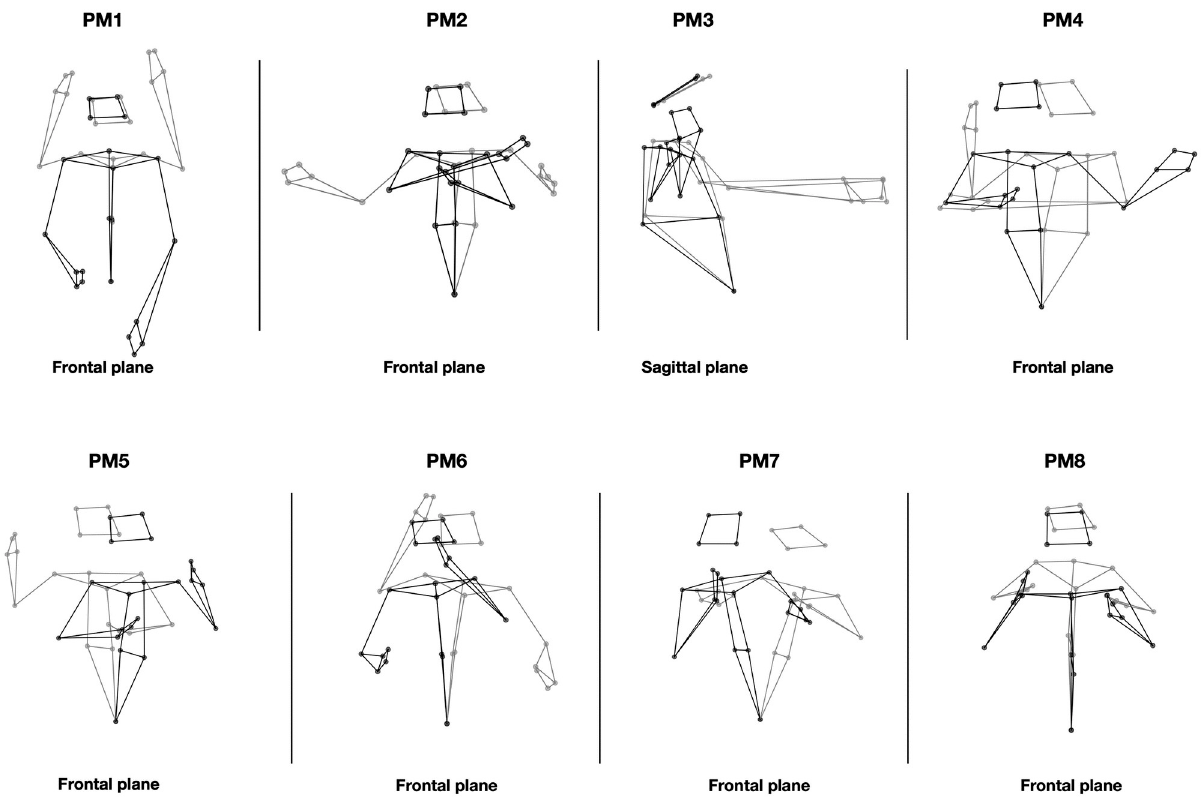
Fig 3. The first eight common PMs. Stick figures represent the PM at the time instants corresponding to the minimum (gray) and the maximum (black) PM weighting, across signers and examples. PMs are displayed in their main plane of motion (e.g., frontal or sagittal).